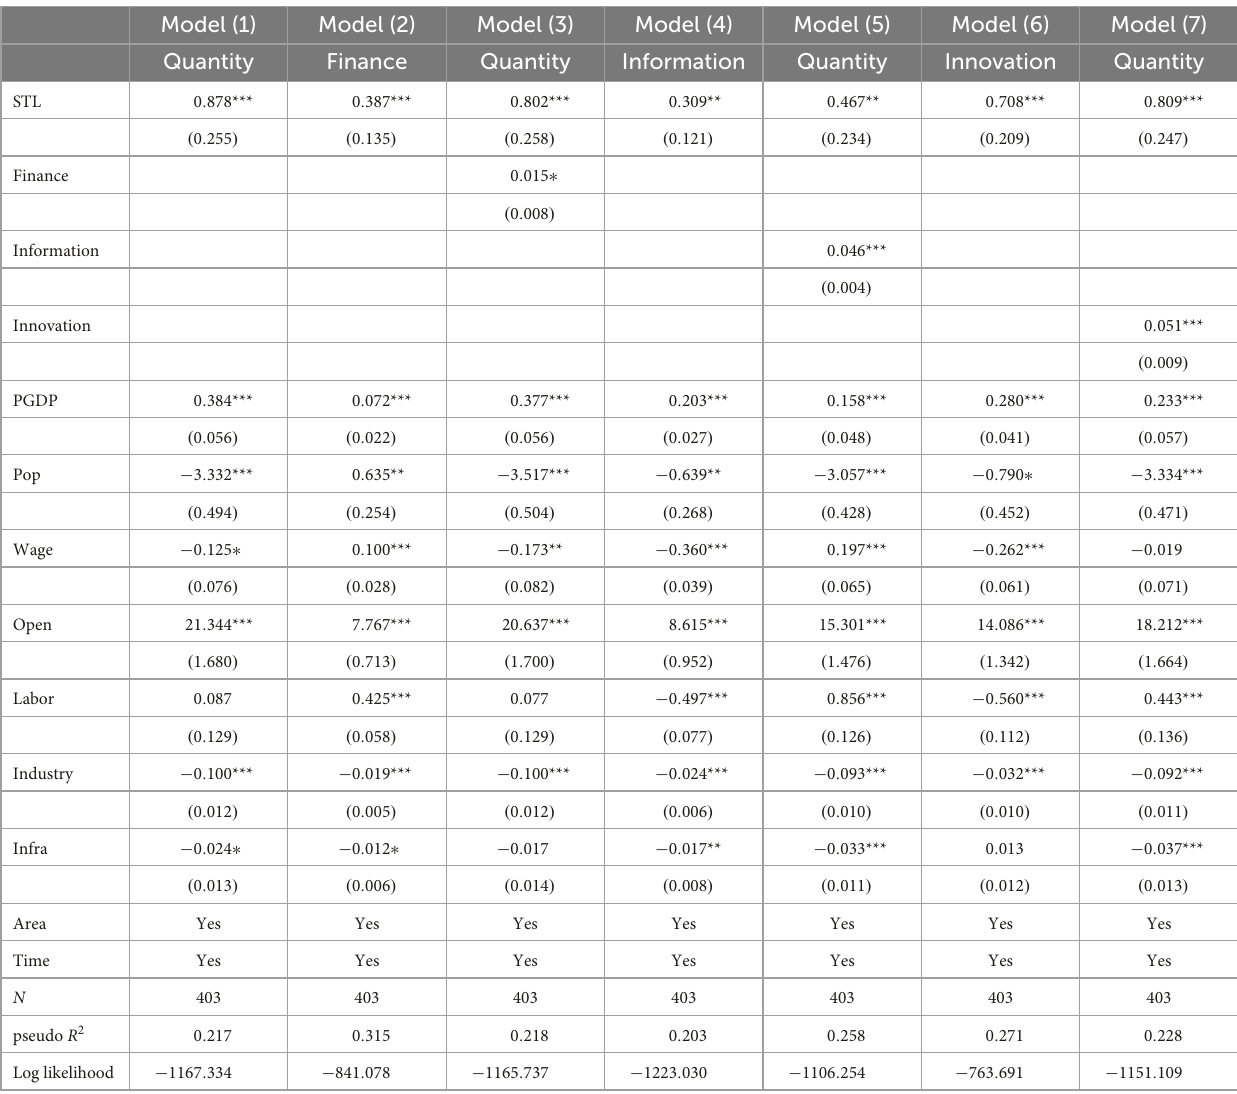
TABLE 6 Regression results for the intermediary